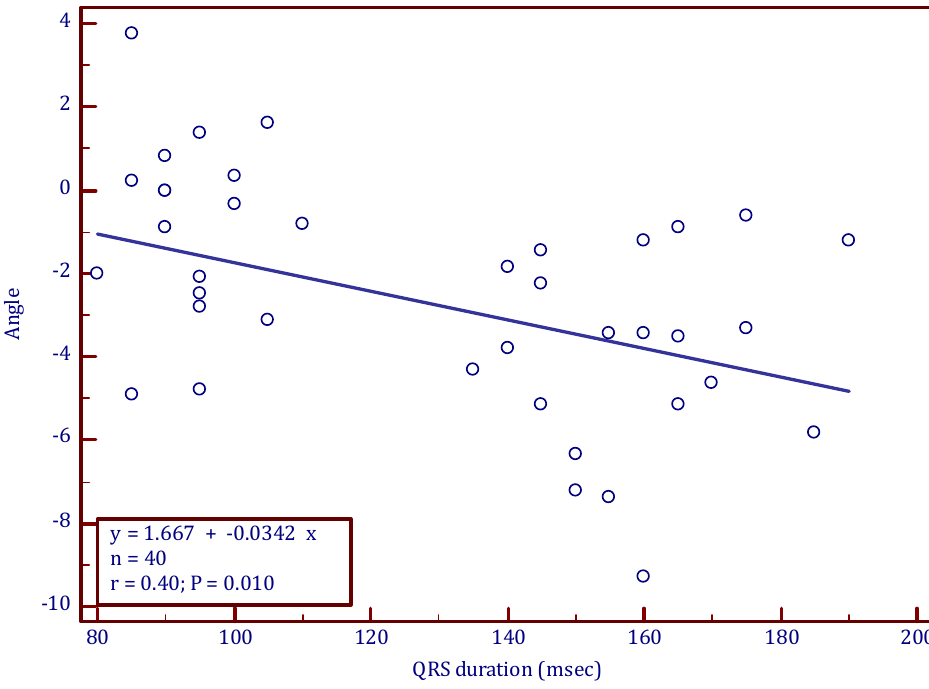
Figure 3. Regression analysis of QRS duration (ms) and longitudinal rotation angle, excluding the CRBBB group.